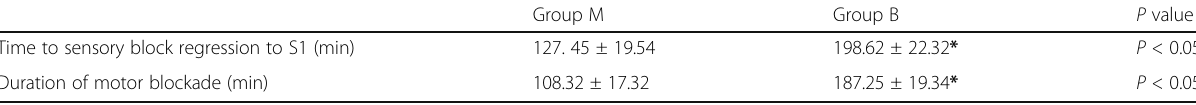
Table 4 Duration of spinal blockade in both groups (data are presented as mean ± SD)